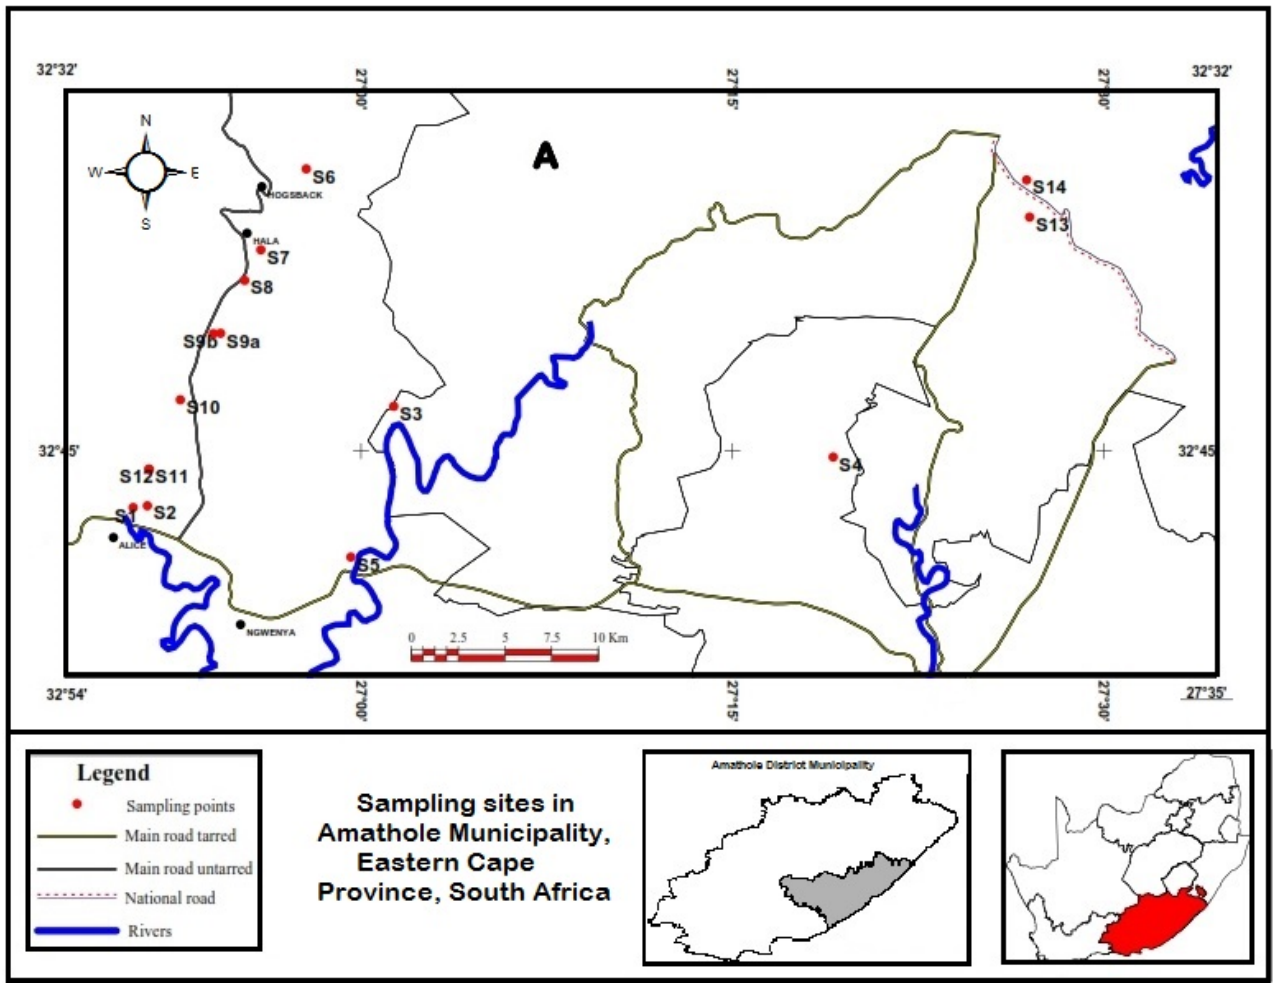
Figure 1. Map showing the sampling sites in Amathole District Municipality (grey area), Eastern Cape Province (red area), South Africa.